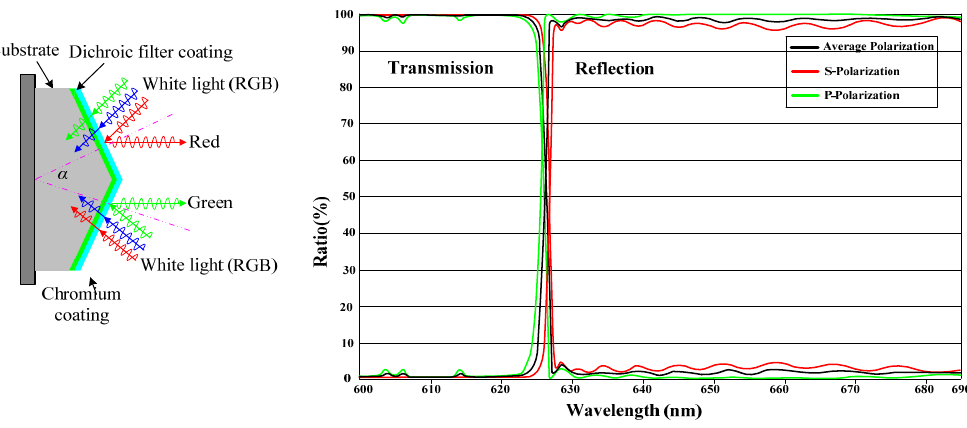
Figure 3. Principle of bi-plane dichroic filter and its filtering performance.